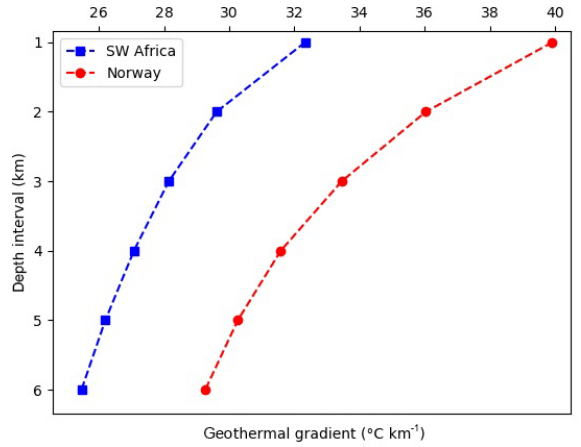
Figure 10. The thermal gradient variations with depth: mean values of the geothermal gradient ( ◦ Ckm − 1 ) across the model area and for the different depth intervals. The temperature–depth distribution maps are presented as Figs. S1 and